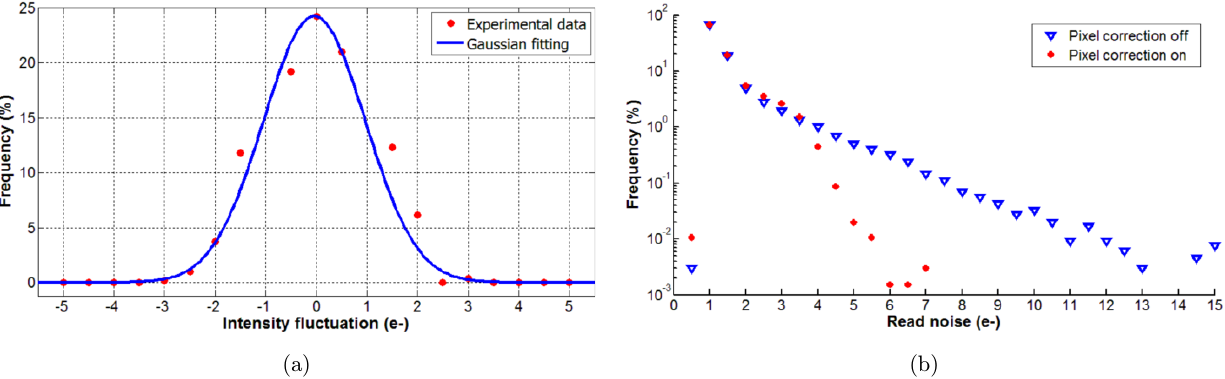
Fig. 5. The temporal read noises from the commercial Hamamatsu Flash 4.0 sCMOS camera. (a) The temporal intensity °uc- tuation histogram of a pixel after o®set reduction. Note that the temporal read noise of the pixel is calculated by the standard deviation of the intensity °uctuation. Here the pixel correction is o®. (b) The histogram of the temporal read noises from a 256x256 pixel region, with and without pixel correction.